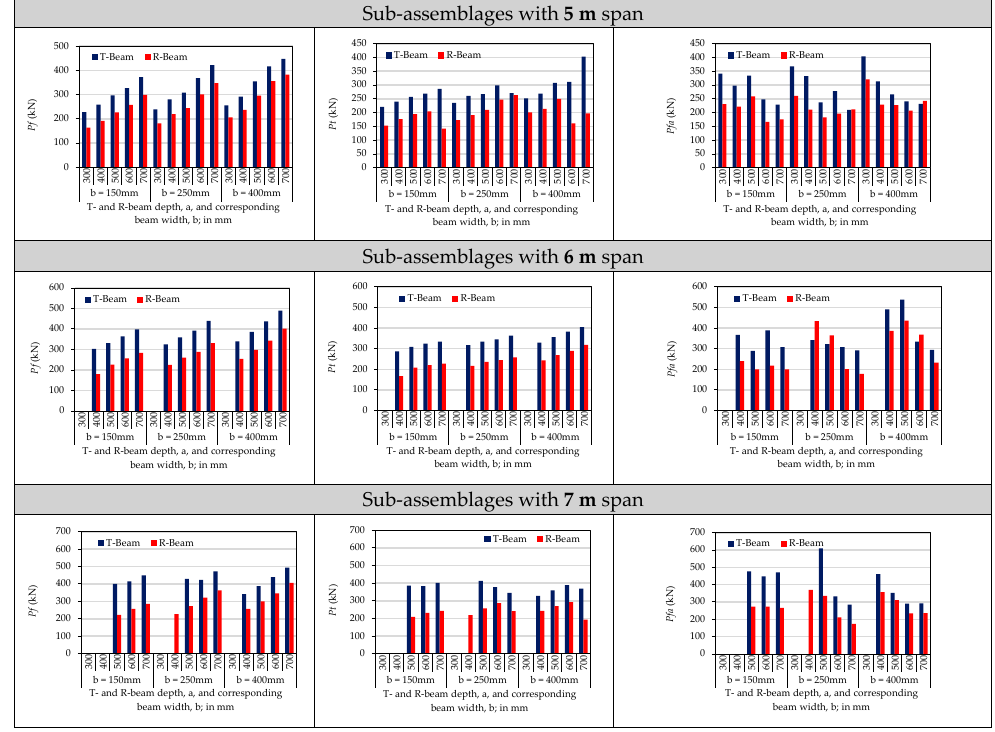
Figure 6. Load capacities of the different sub-assemblage designs. Subassemblage with T-beam configuration Subassemblage with R-beam configuration Sub-assemblages with 5 m span